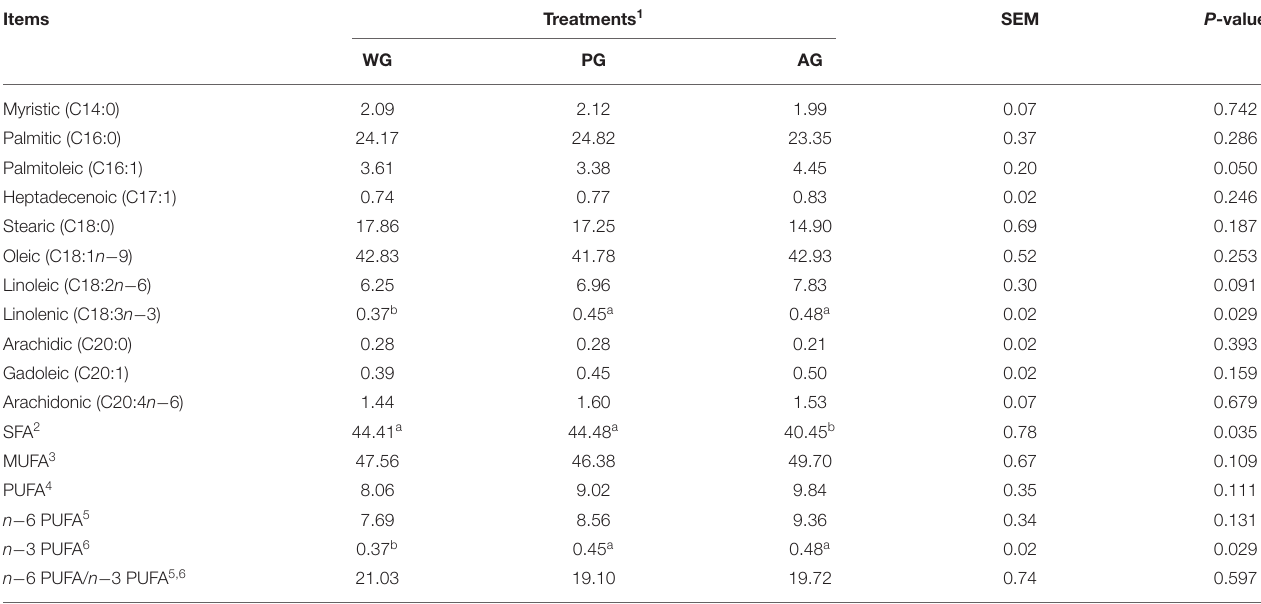
TABLE 4 | Fatty acid composition of longissimus dorsi muscle from Simmental crossbred steers fed different roughage diets. Items Treatments 1 SEM P -value WG PG AG